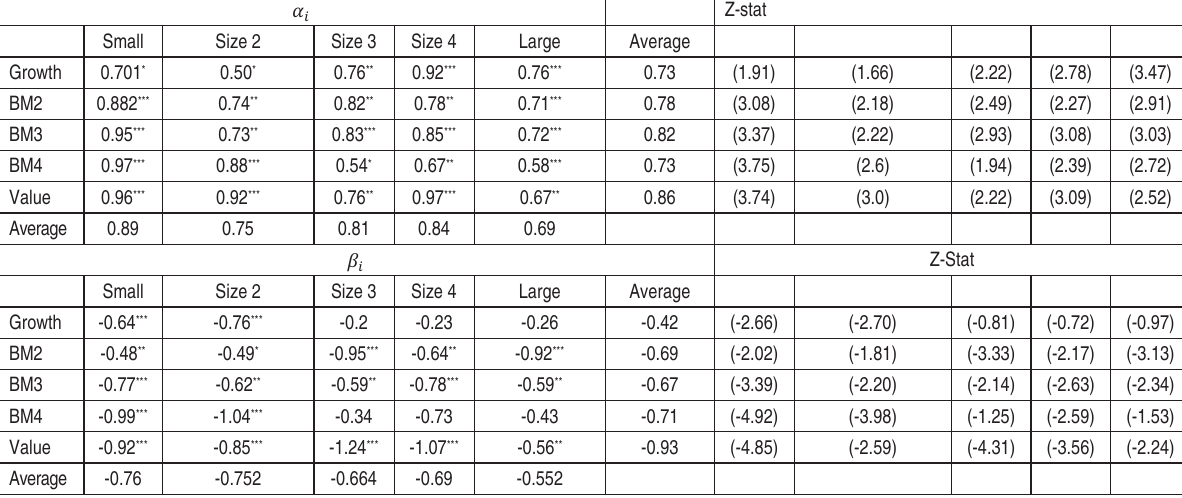
Table 3. The impact of monetary policy shocks on the ERP of the 25 value-weighted Fama-French portfolios